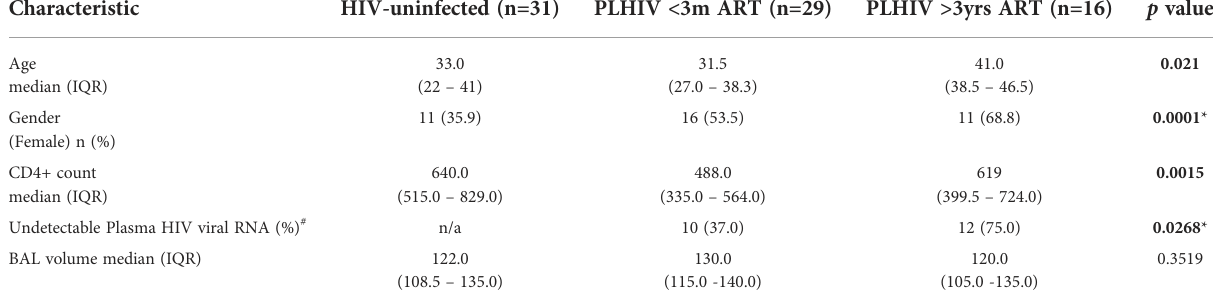
TABLE 1 Demographic and laboratory characteristics of the